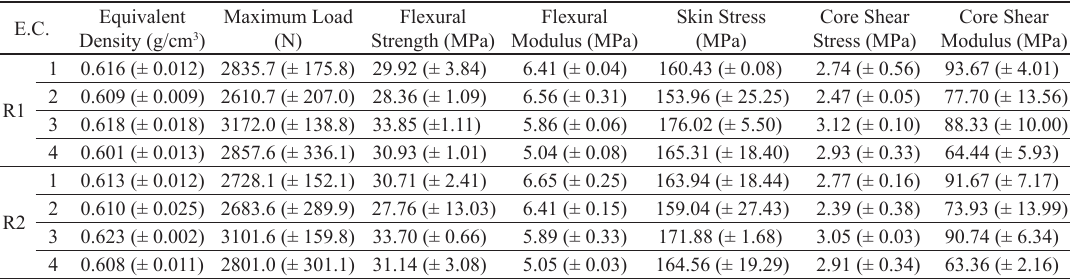
Table 3. Mean and standard deviation values for DoE responses.